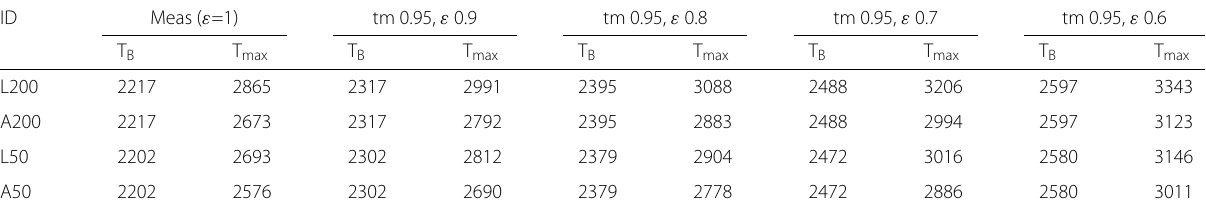
Table 3 Measured and corrected temperatures of MLB surface